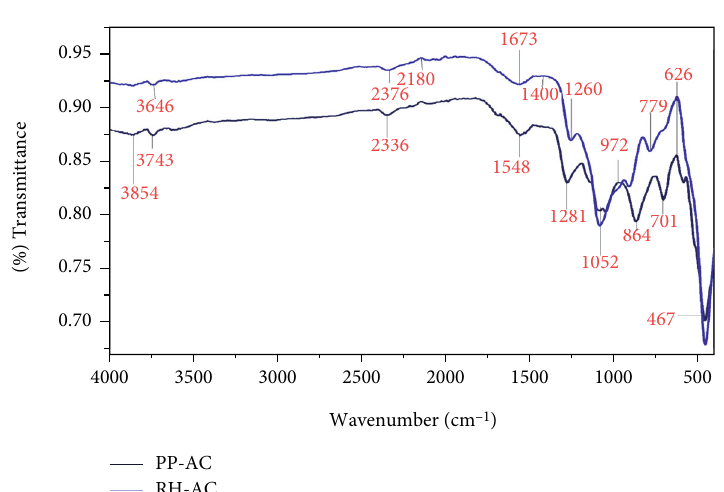
Figure 7: The IR spectra for RH-AC and PP-AC, respectively.